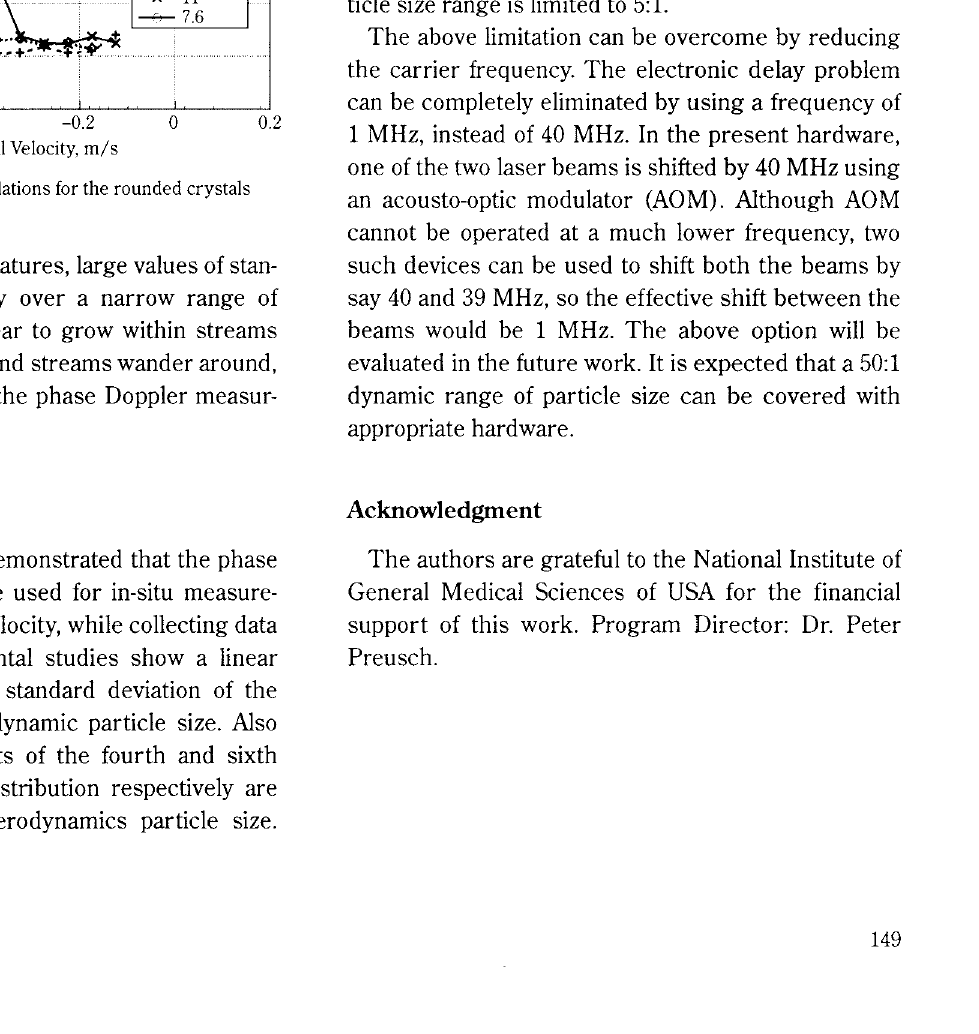
Fig. 9 SEM micrograph of the rounded crystals